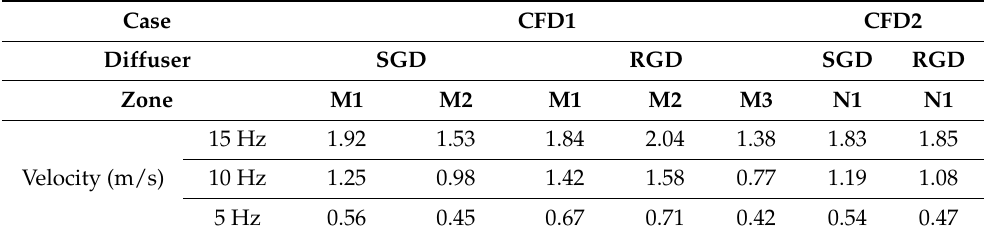
Table 2. Flow boundary conditions for different grille diffusers.